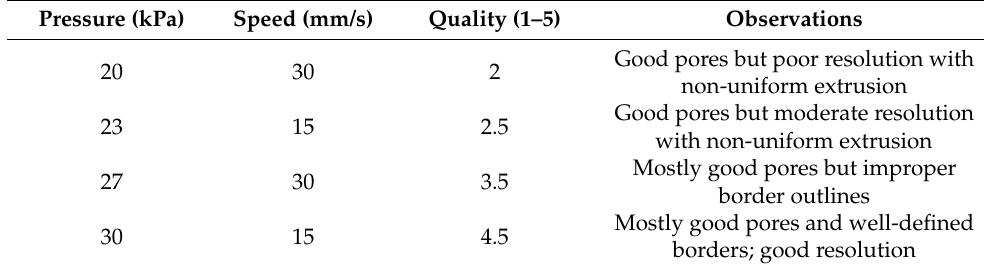
Table 5. Observations of the A12-G6 bioprinted scaffold based on different printing parameters. The quality (print resolution) of the constructs were rated on a scale from 1 to 5, with 1 being the lowest resolution and 5 being the